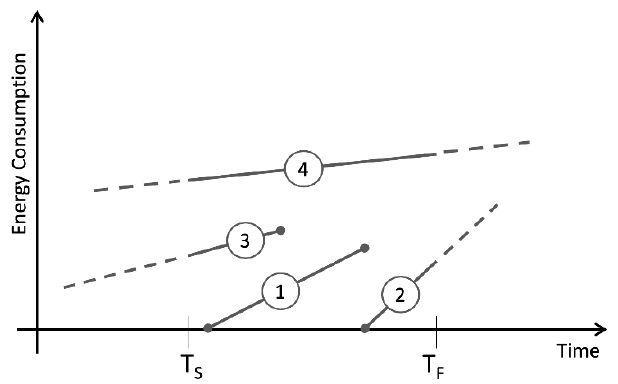
Figure 5. Different conditions in the window width.